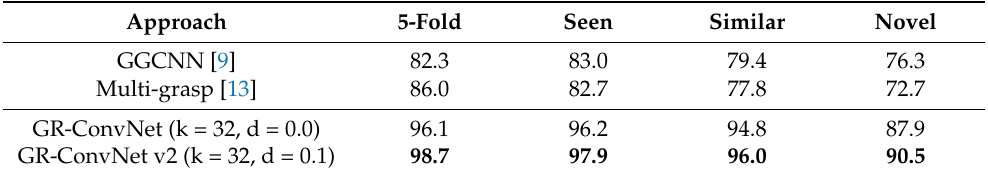
Table 6. Comparative results for grasp prediction accuracy (%) on Graspnet 1-billion dataset for different validation splits. Approach 5-Fold Seen Similar Novel GGCNN [9] 82.3 83.0 79.4 76.3 Multi-grasp [13] 86.0 82.7 77.8 72.7 GR-ConvNet (k = 32, d = 0.0) 96.1 96.2 94.8 87.9 GR-ConvNet v2 (k = 32, d =